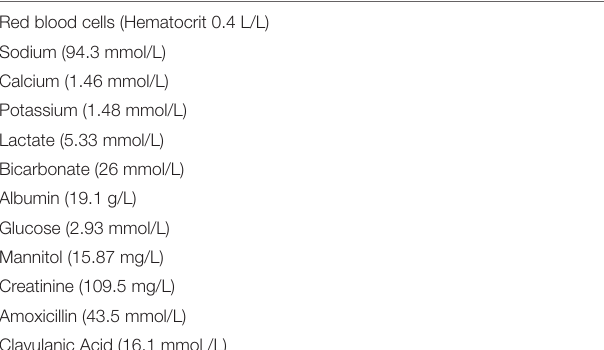
TABLE 1 | Composition of perfusion fluid. Red blood cells (Hematocrit 0.4